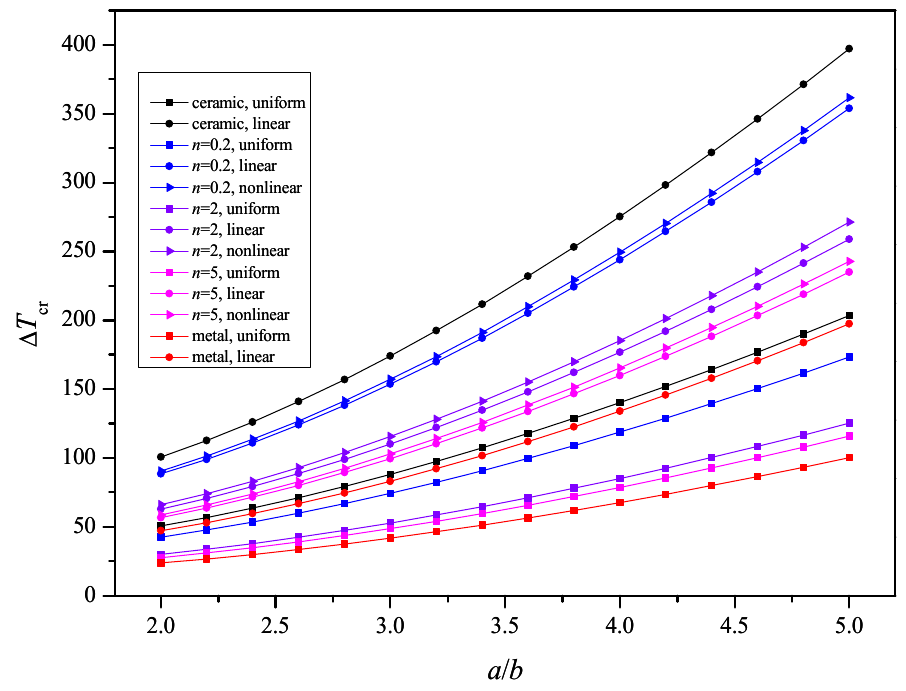
Figure 4. The relation between the critical buckling temperature Δ T cr and power law index n of type ‐ I FGM rectangular thin plate ( a / h = 100, a / b = 2, T 0 = 300 K).